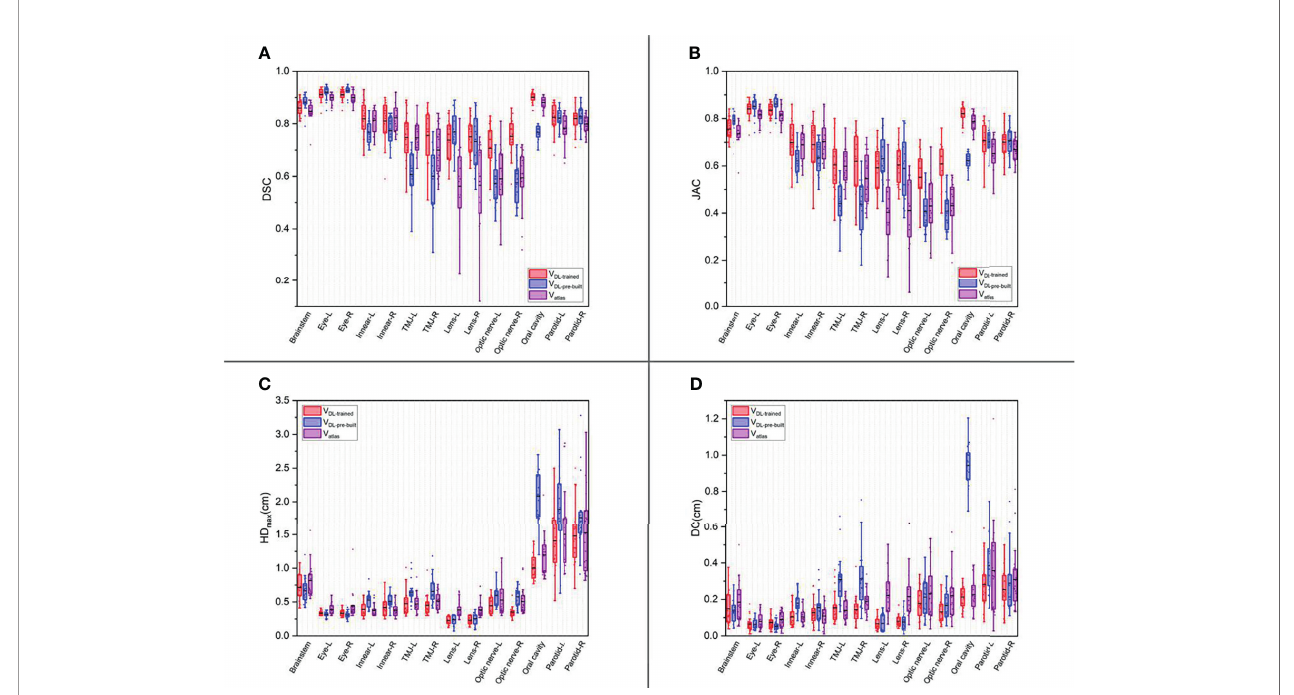
FIGURE 3 | The box plots of four quantitative evaluation parameters of the OARs for the three segmentation methods. The results of DSC are listed in (A) , JAC in (B) , HD max in (C) , and DC in (D) . The results of the trained DL-based model are depicted in red, the pre-built DL-based model in blue, and the atlas-based auto- segmentation in purple.